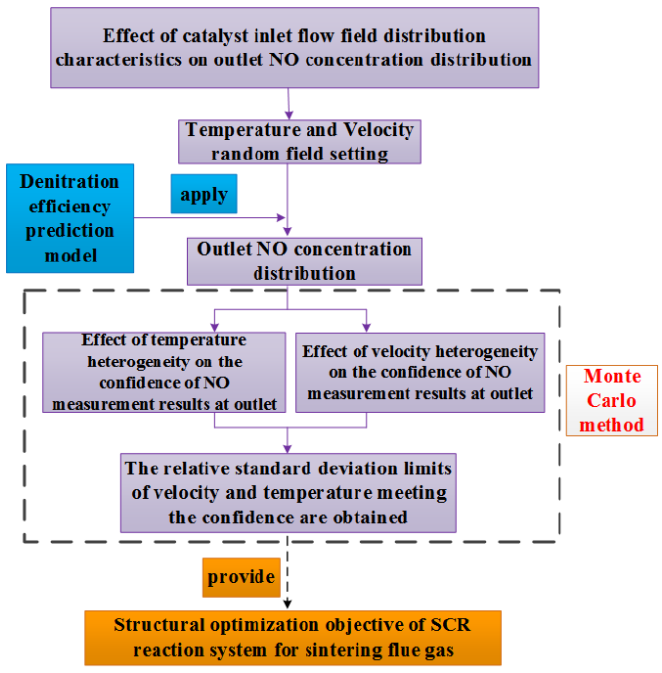
Figure 2. Schematic diagram of research routes.